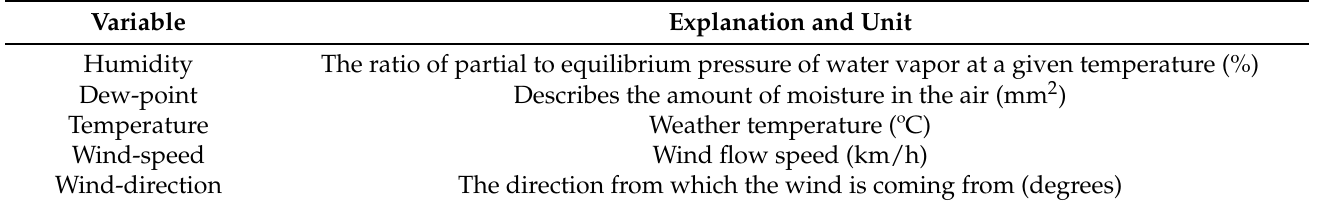
Table 4. Variables and their explanations for meteorology related